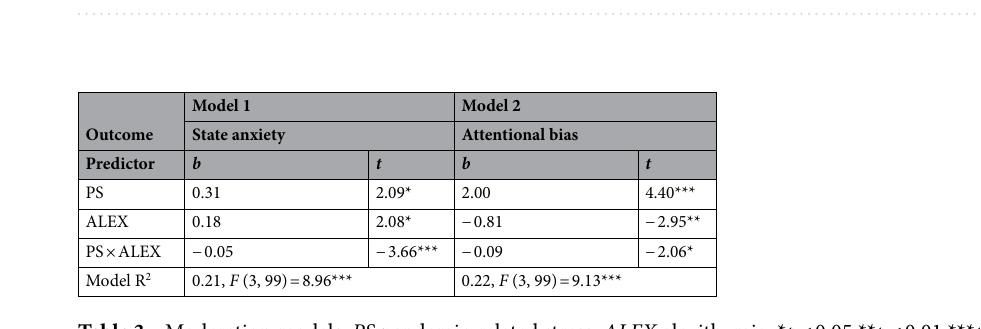
Table 2. Descriptive statistics and intercorrelations among all variables. N = 103; M mean, SD standard deviation. * p < 0.05, ** p < 0.01, *** p < 0.001.